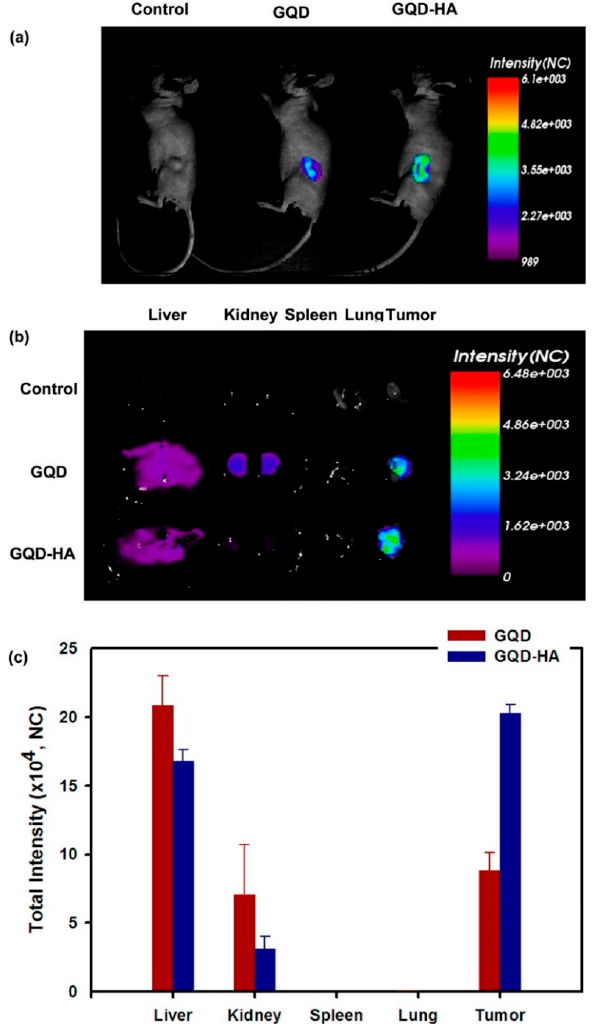
Figure 3. ( a ) In vivo fluorescence images of GQD-HA in mice after tail vein injection; ( b ) Ex vivo images of liver, kidney, spleen, heart, and tumor after dissection; ( c ) Normalized intensity from